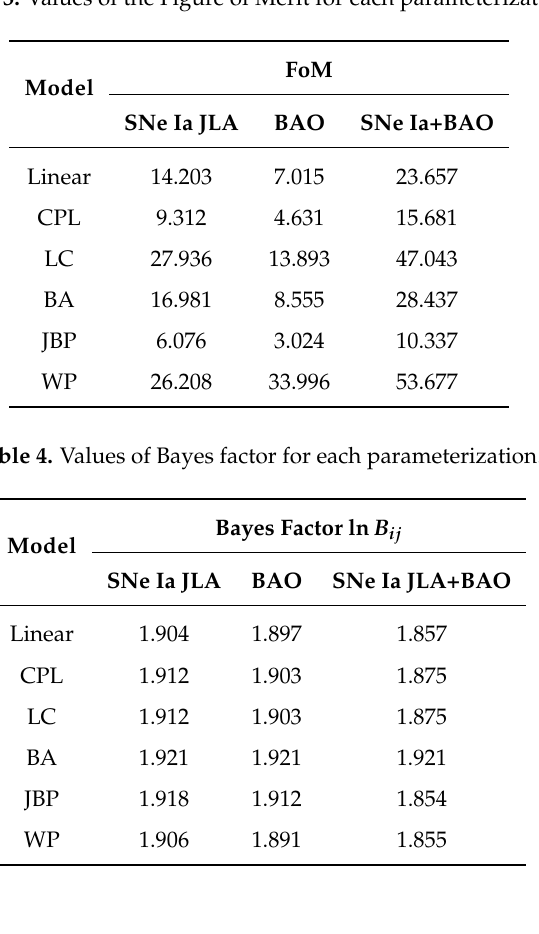
Table 3. Values of the Figure of Merit for each parameterization.